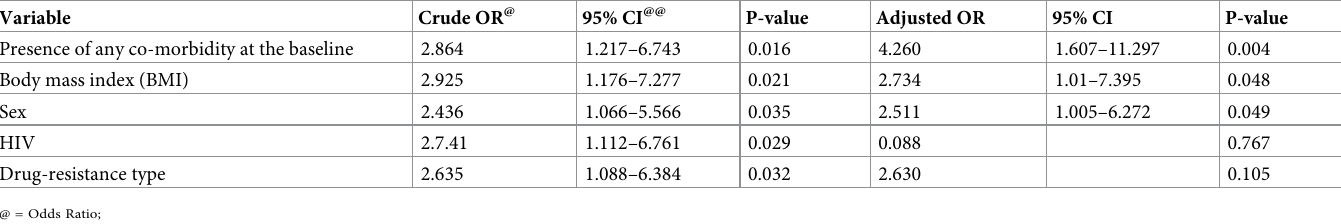
Table 4. Results of the multivariable analysis using logistic regression on factors associated with unfavourable MDR-TB treatment outcome of the study partici- pants at Adama and Nekemte referral hospitals, Oromia, Ethiopia, December 2012 –September 2016. Variable Crude OR @ 95% CI @@ P-value Adjusted OR 95% CI P-value Presence of any co-morbidity at the